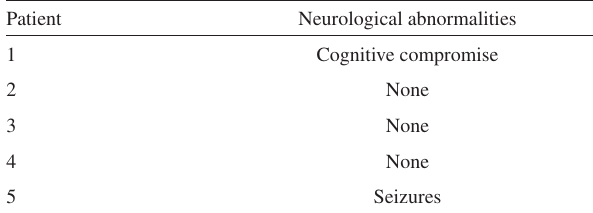
Table 3 - Neurological